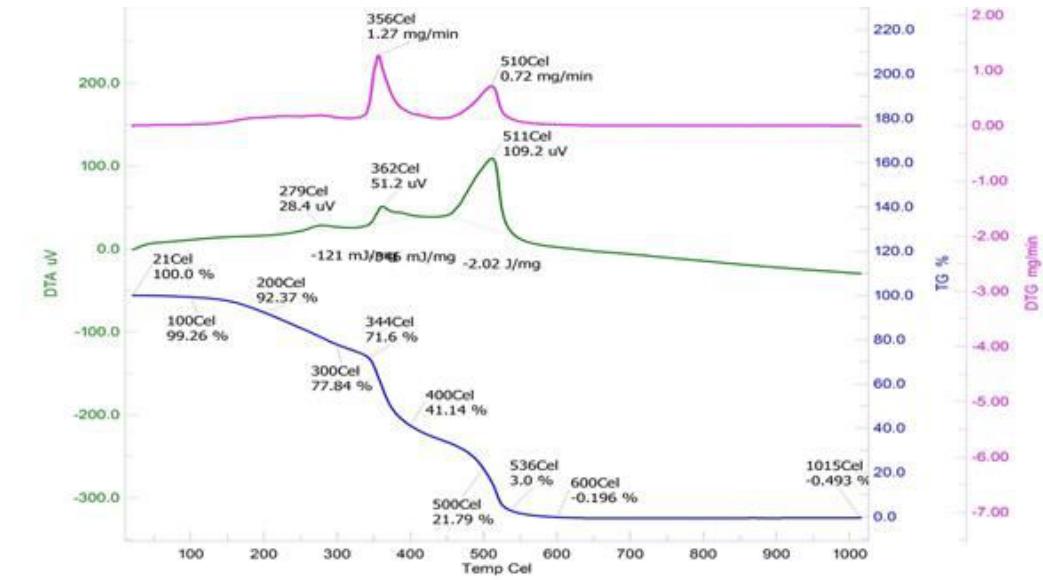
Figure 10: Thermal analysis of neat